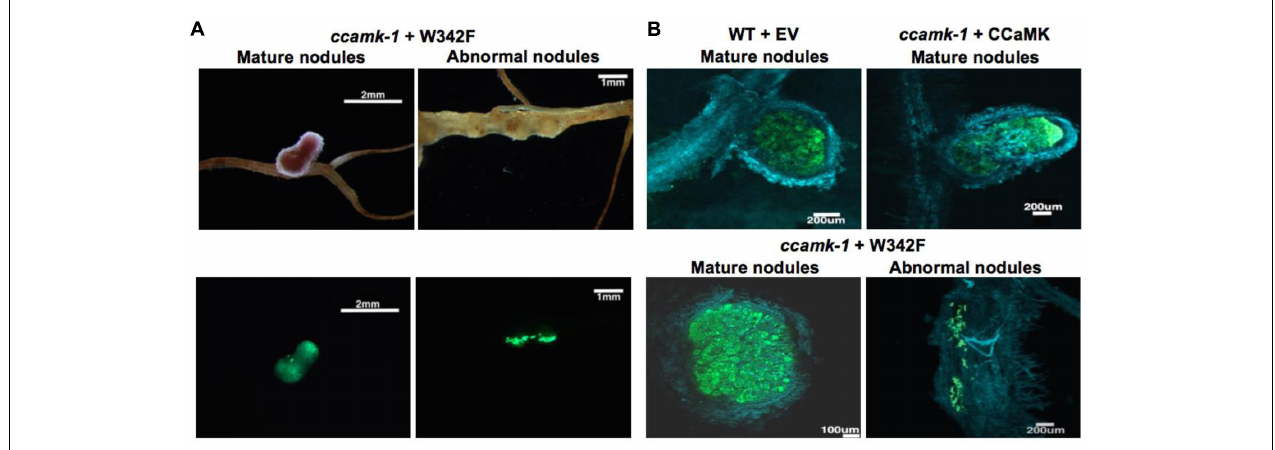
FIGURE 5 | (A) Morphological differences in nodules produced on roots complemented with W342F and CCaMK; (B) Confocal microscopic images of mature nodules from roots of wild-type Medicago truncatula and ccamk-1 knockout complemented with CCaMK and W342F mutant. Blue color indicates cell wall tissue stained with Calcofluor white. Green color shows living S. meliloti